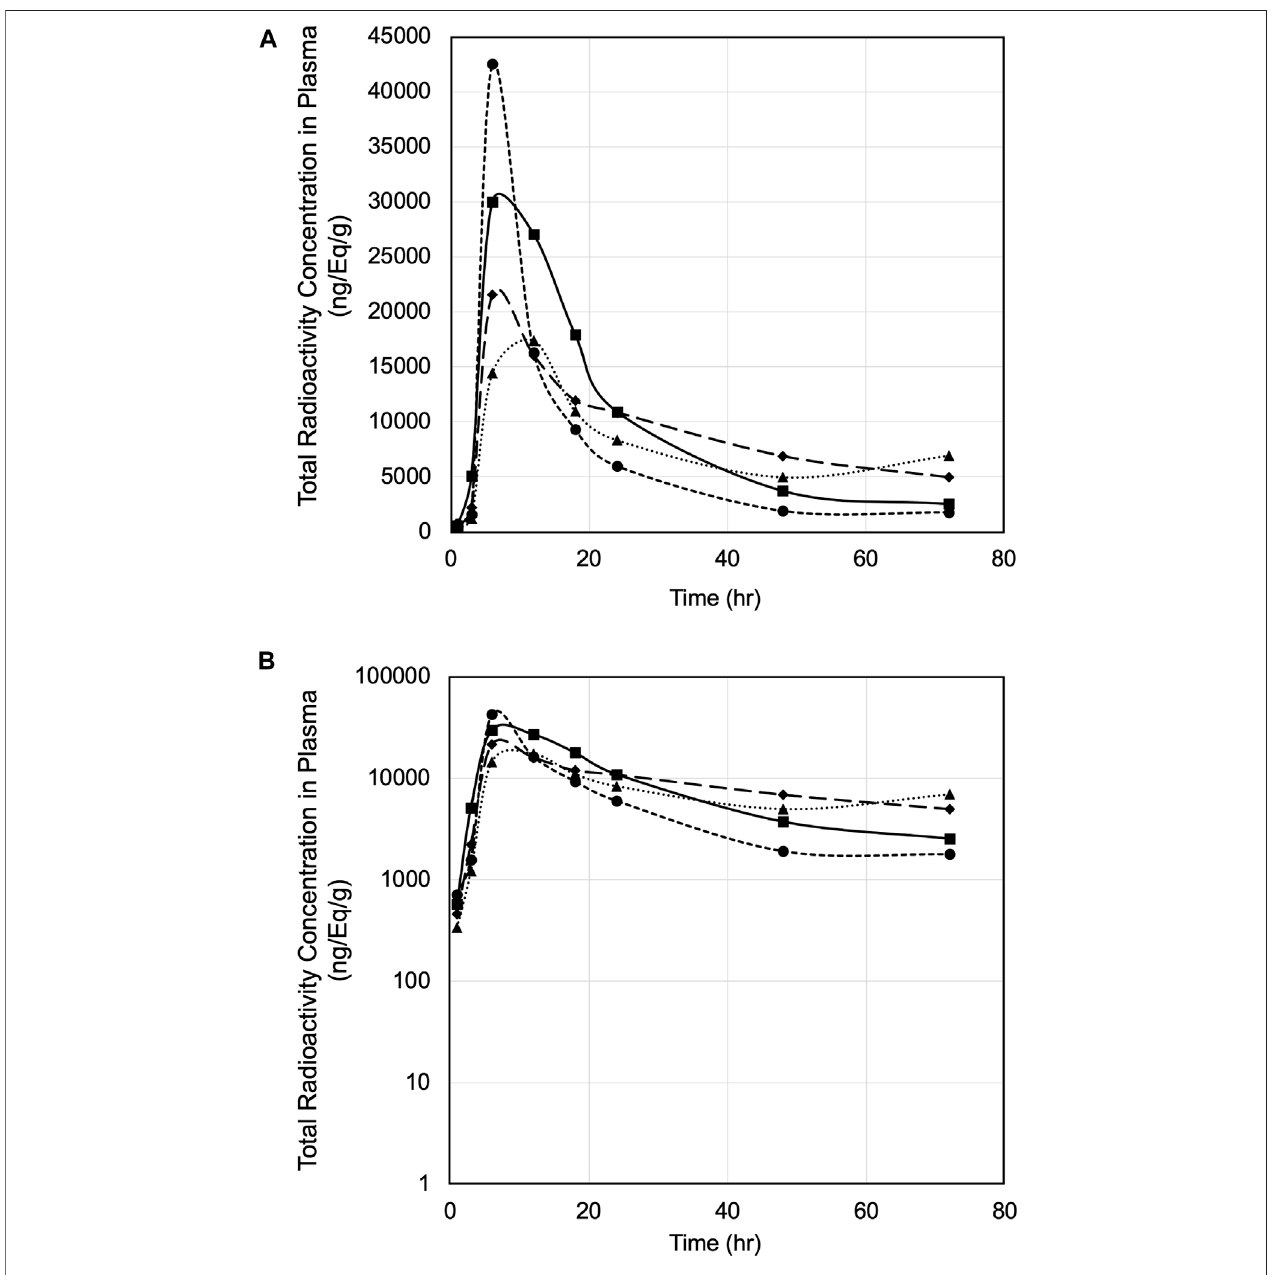
FIGURE 1 | (A) Plasma concentration versus time of [ 14 C]PPI-1011 in four male rats following single-dose oral administration at 100 mg/kg. (B) Log10 scale of A.